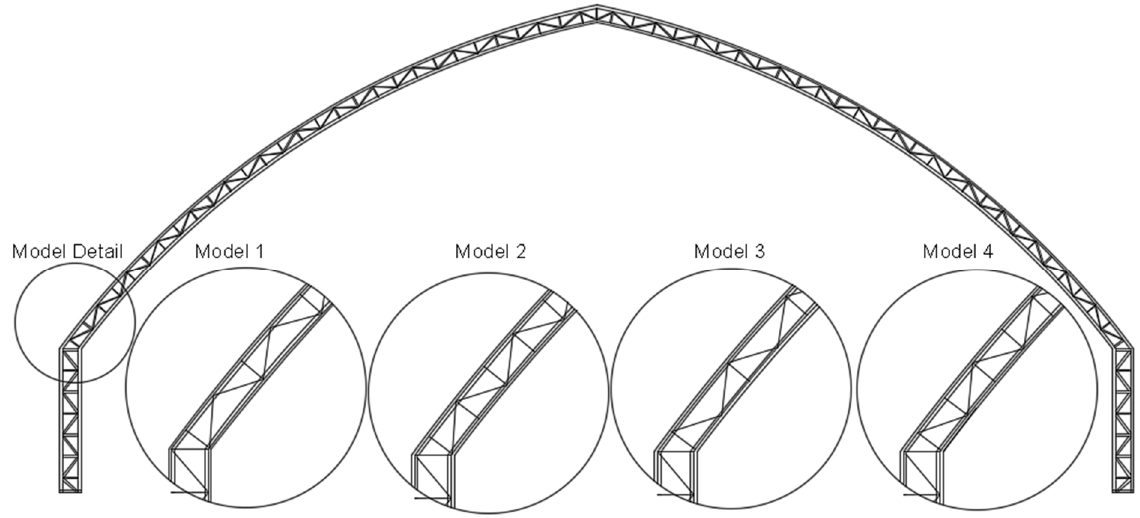
Figure 2. Di ff erent con fi gurations of the rafter